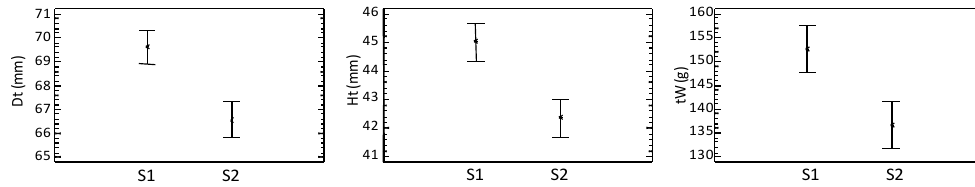
Figure 3. Mean size (test diameter Dt and height Ht in mm) and biomass (total weight tW in g) ± Fisher LSD of the sea urchin Sphaerechinus granularis in S1 and S2 sampling stations of Pagasitikos Gulf.